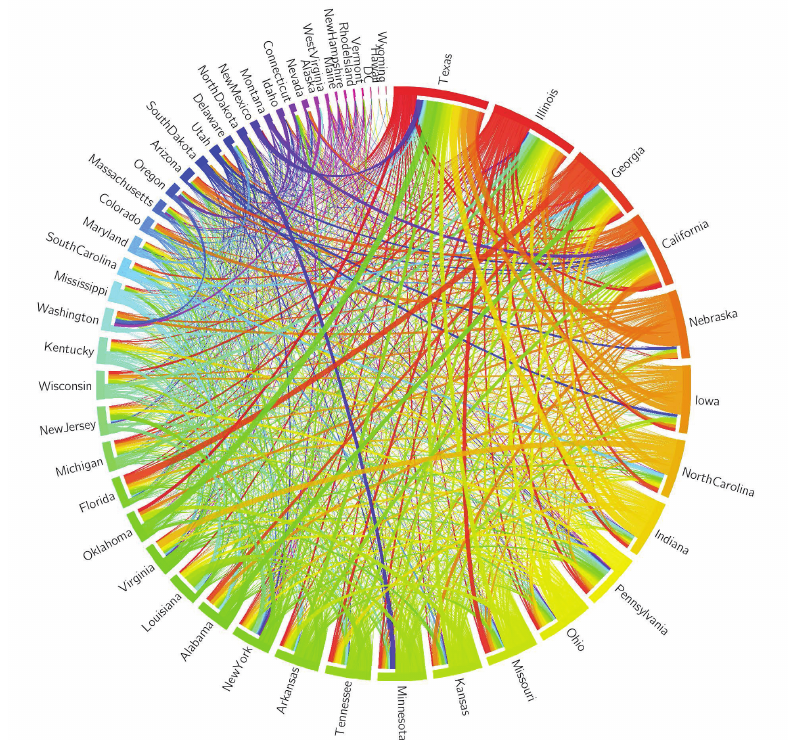
Figure 2. Agricultural virtual water flows between states in the United States. States are ranked according to the total virtual water flow volume and plotted clockwise in descending order. The size of the outer bar indicates the total virtual water flow volume of each state as a percentage of total US virtual water flows. Links emanating from the outer bar of the same color show outflows. Links with a white area separating the outer bar from links of a different color illustrate inflows. The volume of virtual water flows captured in this graph is 317 billion m 3 year − 1 . This figure is taken from Dang et al. [56] and is circa